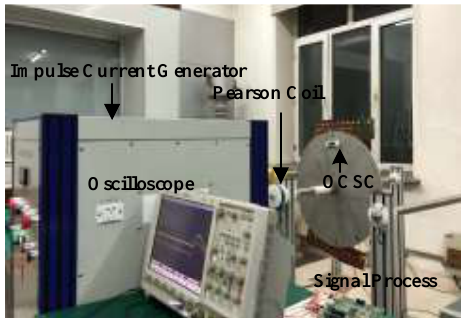
Figure 11. Impulse current measurement experimental platform.